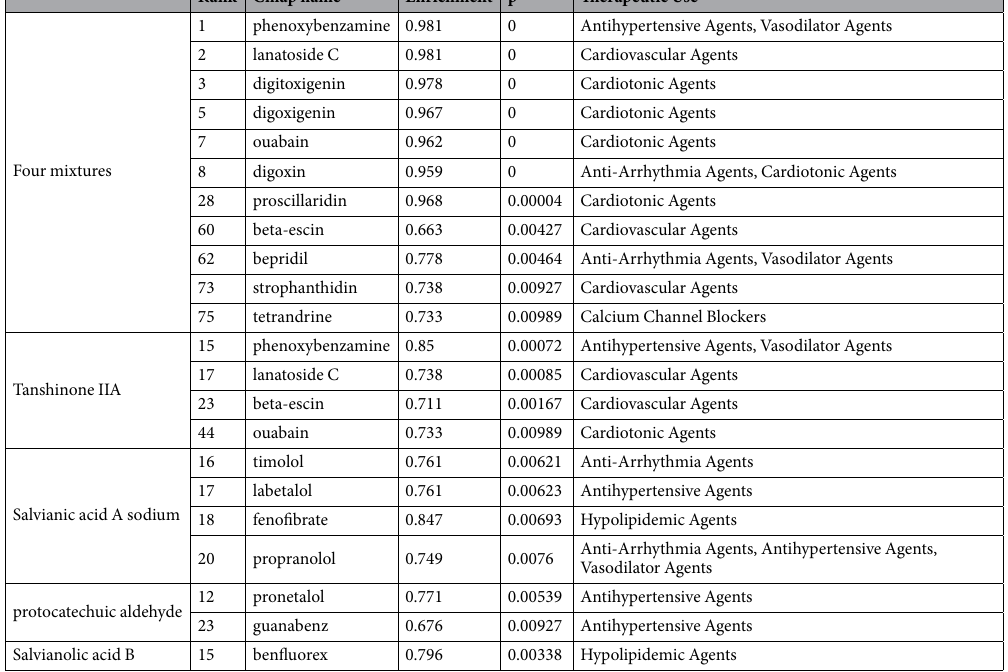
Table 3. Results of CMAP